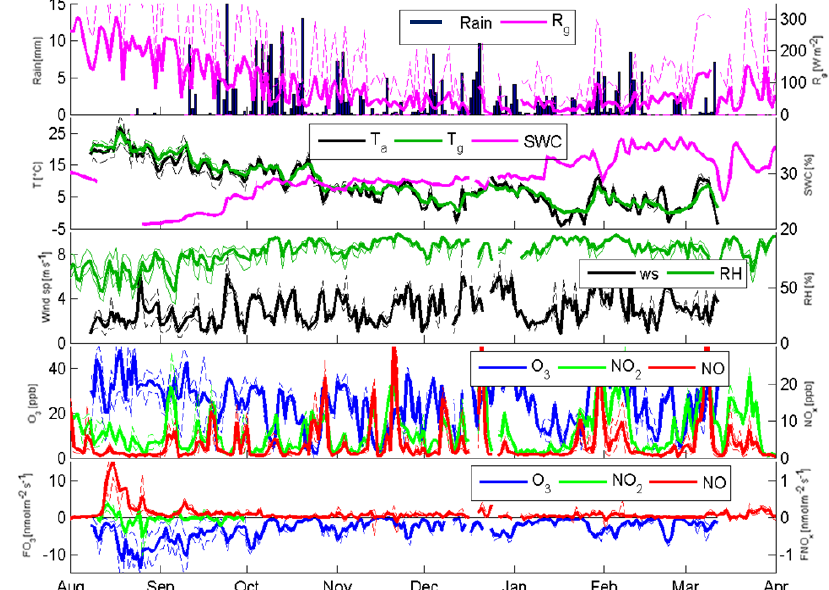
Figure 4. Meteorological and soil conditions (daily averages, sums for rainfall), NO, NO 2 and O 3 mixing ratios and fluxes during the entire measurement period from 7 August 2012 to 13 March 2013 at the Grignon field site. Averages for night-time and daytime are also given as dotted lines. R g is the global radiation, T a and T g the air and ground temperature, SWC the soil water content, ws the wind speed, RH the air relative